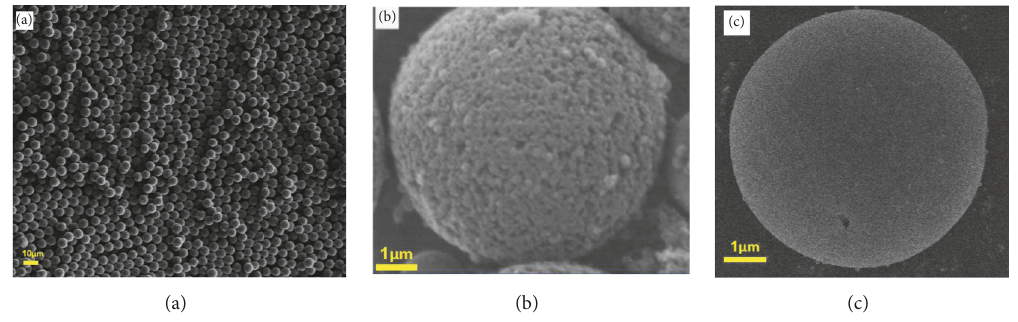
Figure 4: Scanning electron micrographs of (a) P